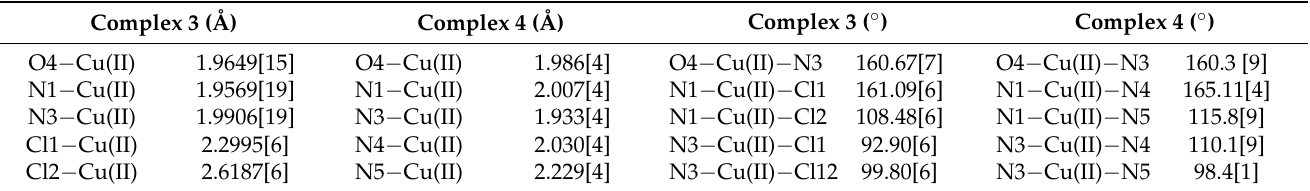
Bond length (Å) and bond angles ( ◦ ) of Complex 3 and Complex 4 at Cu(II) coordination.sites